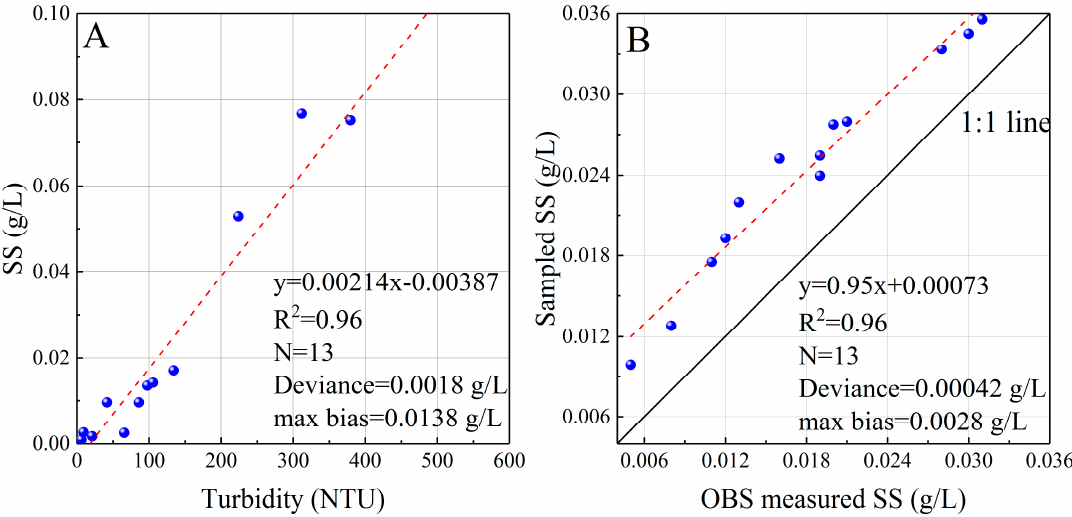
Figure 3. Regression results between turbidity measured by the OBS sensors and the suspended solids (SS) obtained from water samples ( A ), and between SS measured by the OBS sensors and the in situ SS obtained in water samples ( B ).